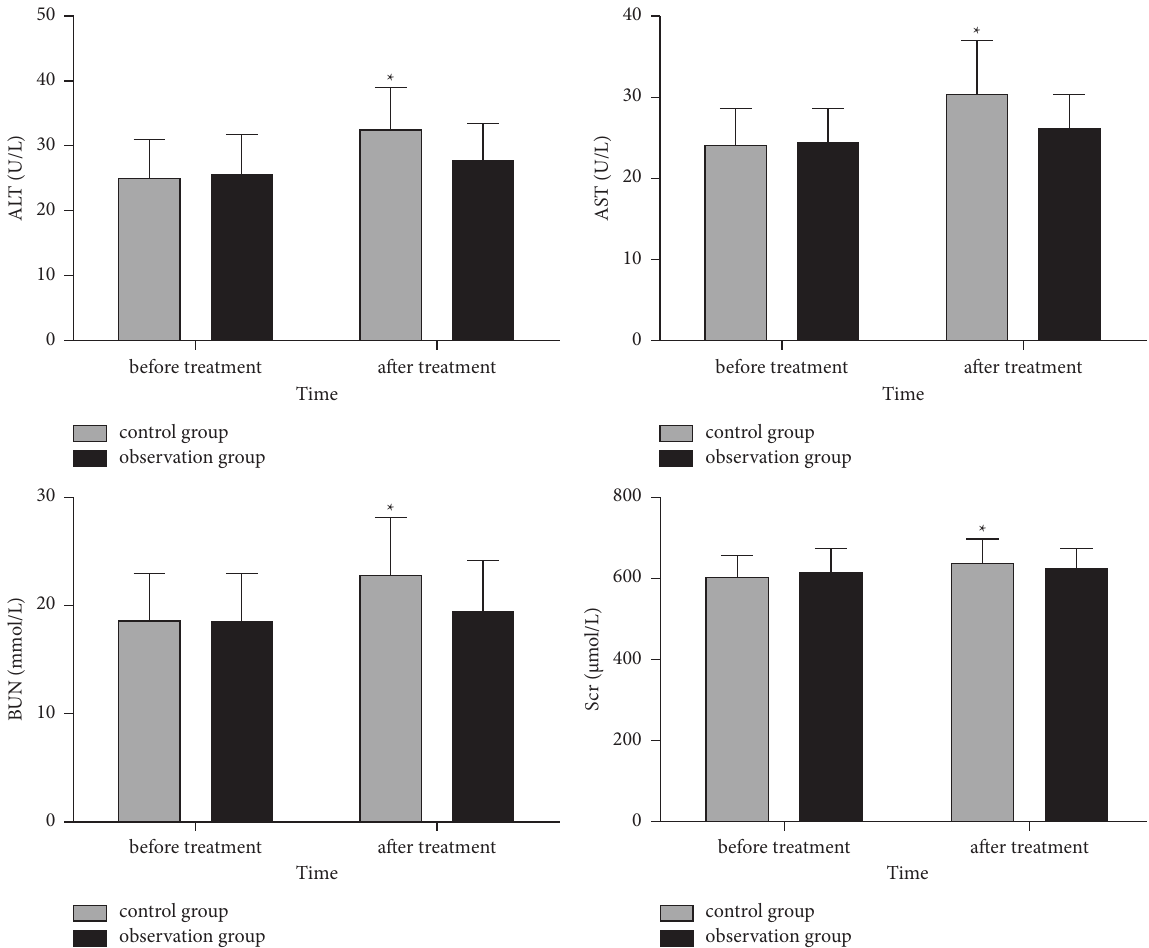
Figure 2: Comparison of liver and kidney function before and after treatment in two groups of patients. Note: compared with before treatment, ∗ P < 0 .